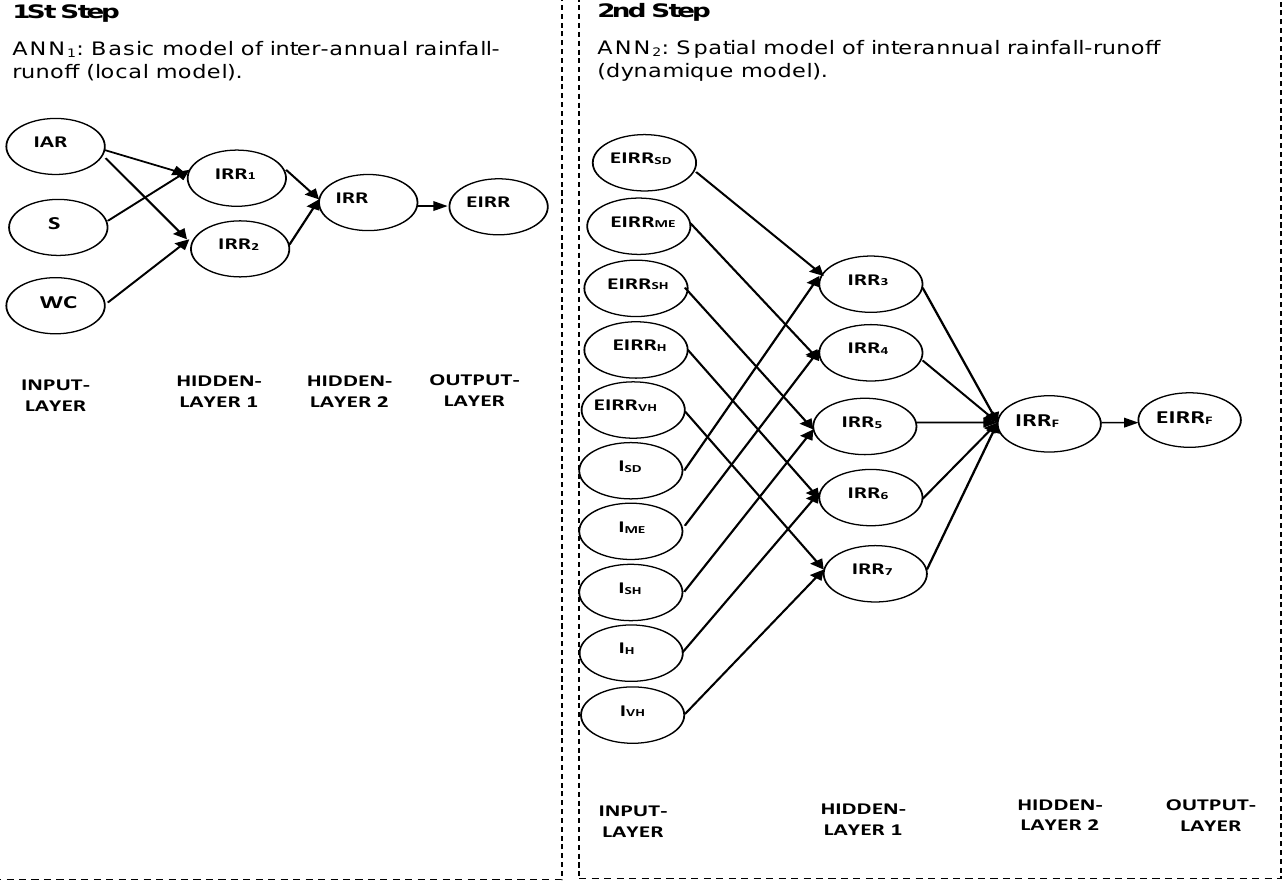
Figure 4. Proposed ANN s model architecture, used to estimate residuals computational of the Ol’Dekop model. The local and basic model (ANN 1 ), general and dynamic model (ANN 2 ). Inter- annual rainfall (IAR), watershed area (S), watercourse (WC), De Martonne index (I), Semi-Dry (SD), Mediterranean (ME), Semi-Humid (SH), Humid (H), and Very Humid (VH). Table 3. Matrix of correlation between inter-annual rainfall-runoff residual data of Ol’Dkop model and hydro-morphological variables selected for the ANN S modeling.